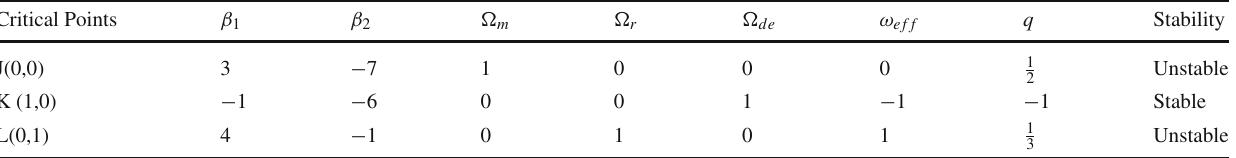
Table 9 Critical points and Eigenvalues for the system of Eqs. (79)–(80) Critical Points β 1 β